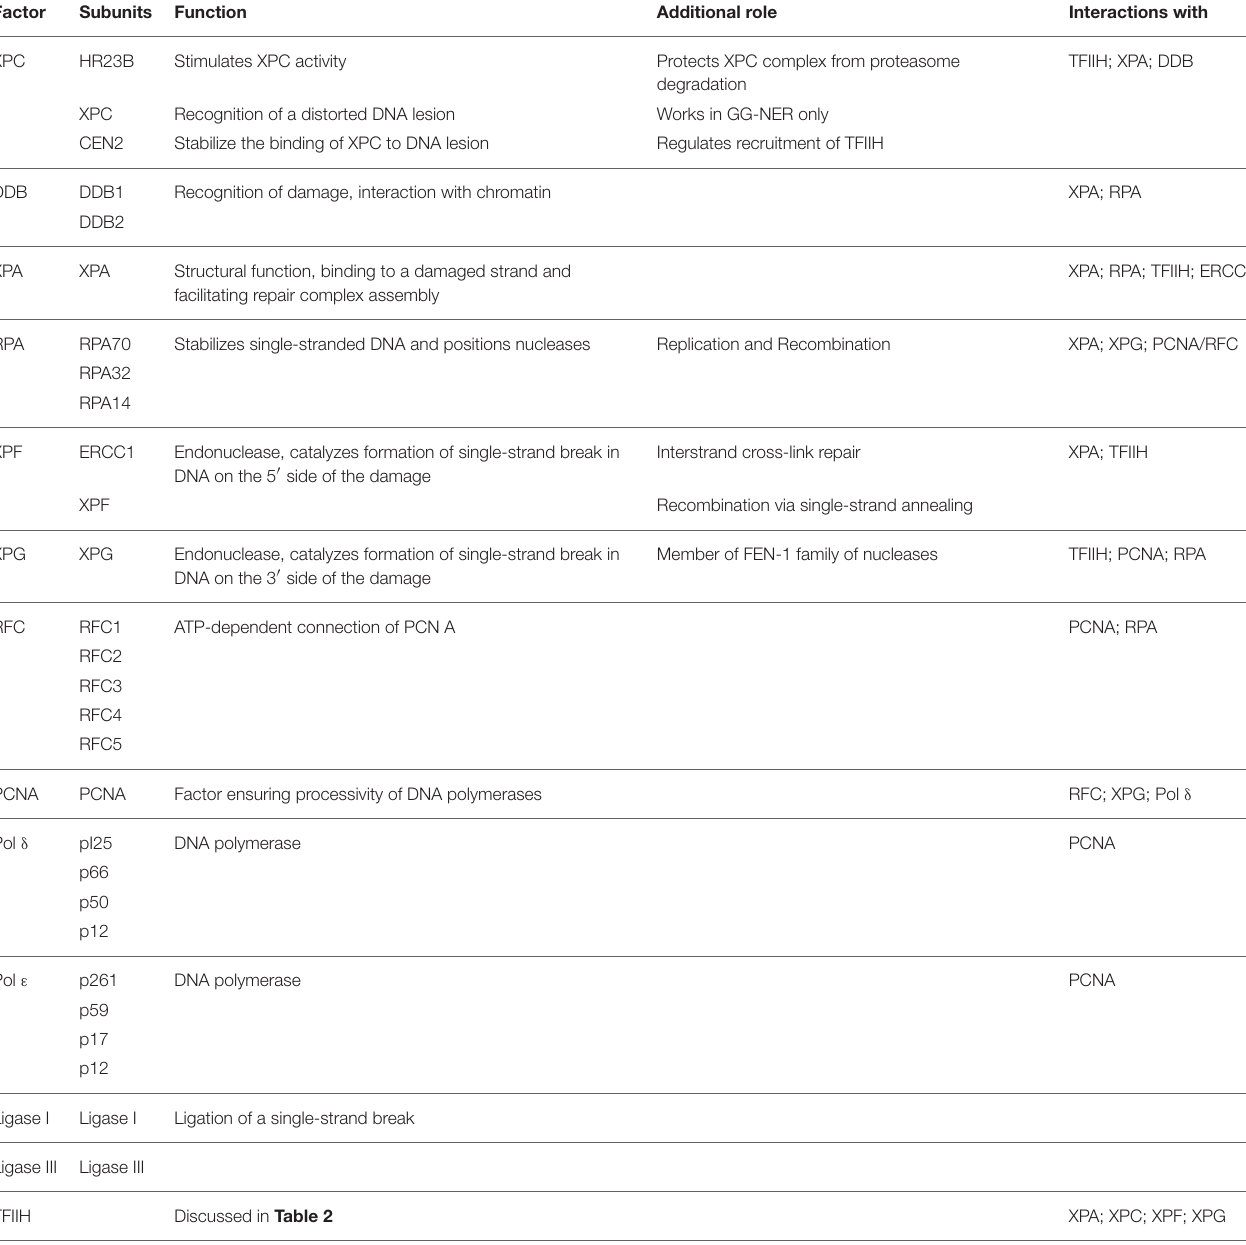
TABLE 1 | Composition of the human NER system. Factor Subunits Function Additional role Interactions with